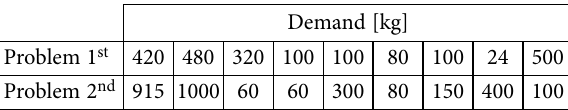
Table 5. Computational results for different numbers of k from classical k -means clustering algorithm (source: current study)